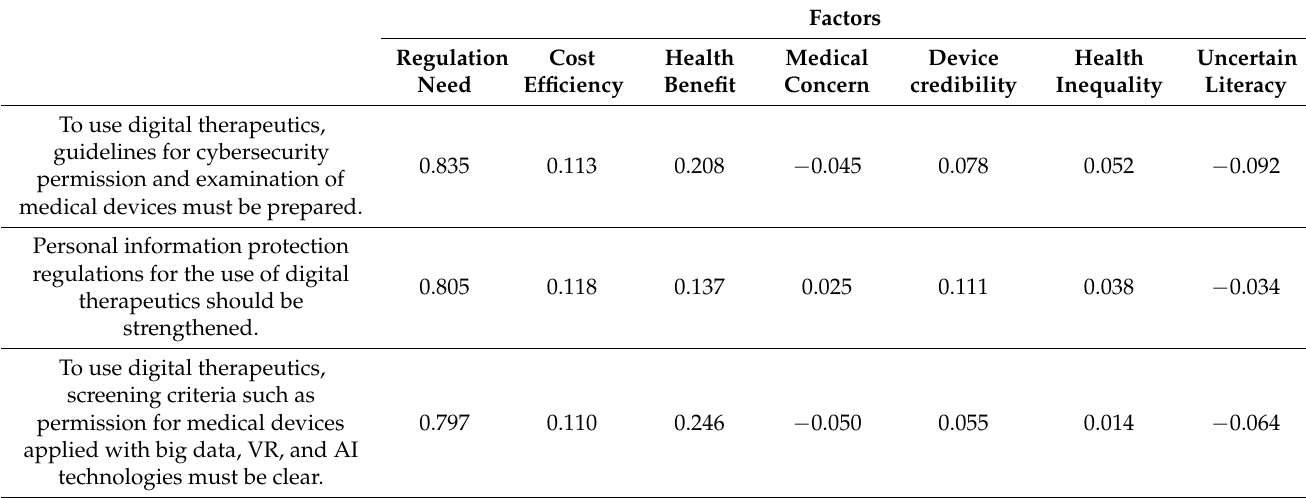
Table 3. The result of exploratory factor analysis: digital therapeutics